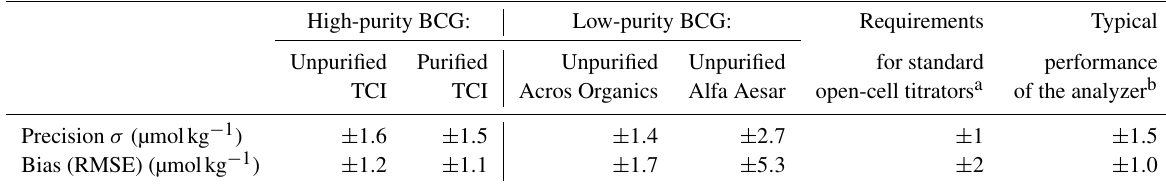
Table 4. Precision and bias of unpurified and purified BCG High-purity BCG: Low-purity BCG: